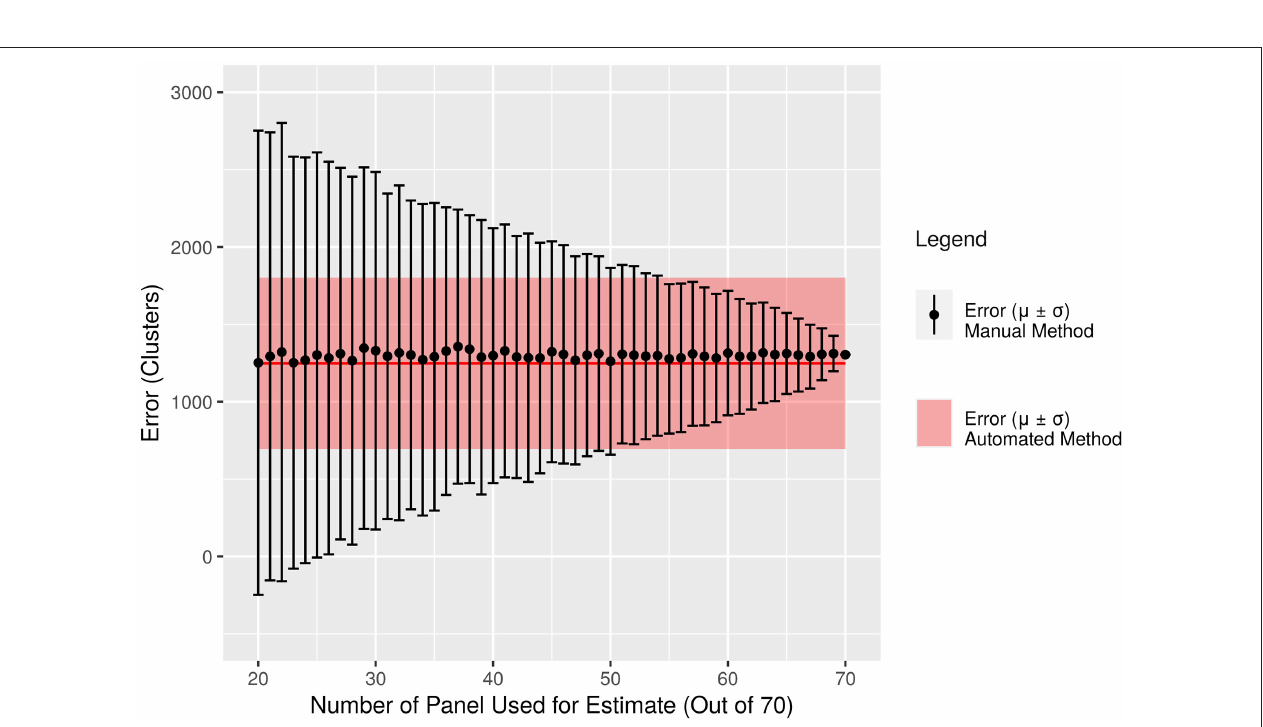
FIGURE 5 | The mean error and standard deviation of the manual method are plotted in black for data collected in 2020. The standard deviation of the error decreases as the number of panels used is increased. The red line represents the mean error of the automated method on the same dataset but only using 20 panels. The red shaded region represents the standard deviation of the automated method using 20 panels.